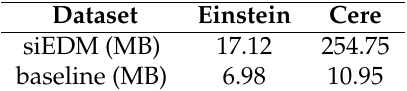
Table 2. Comparison of the memory consumption for the query search.